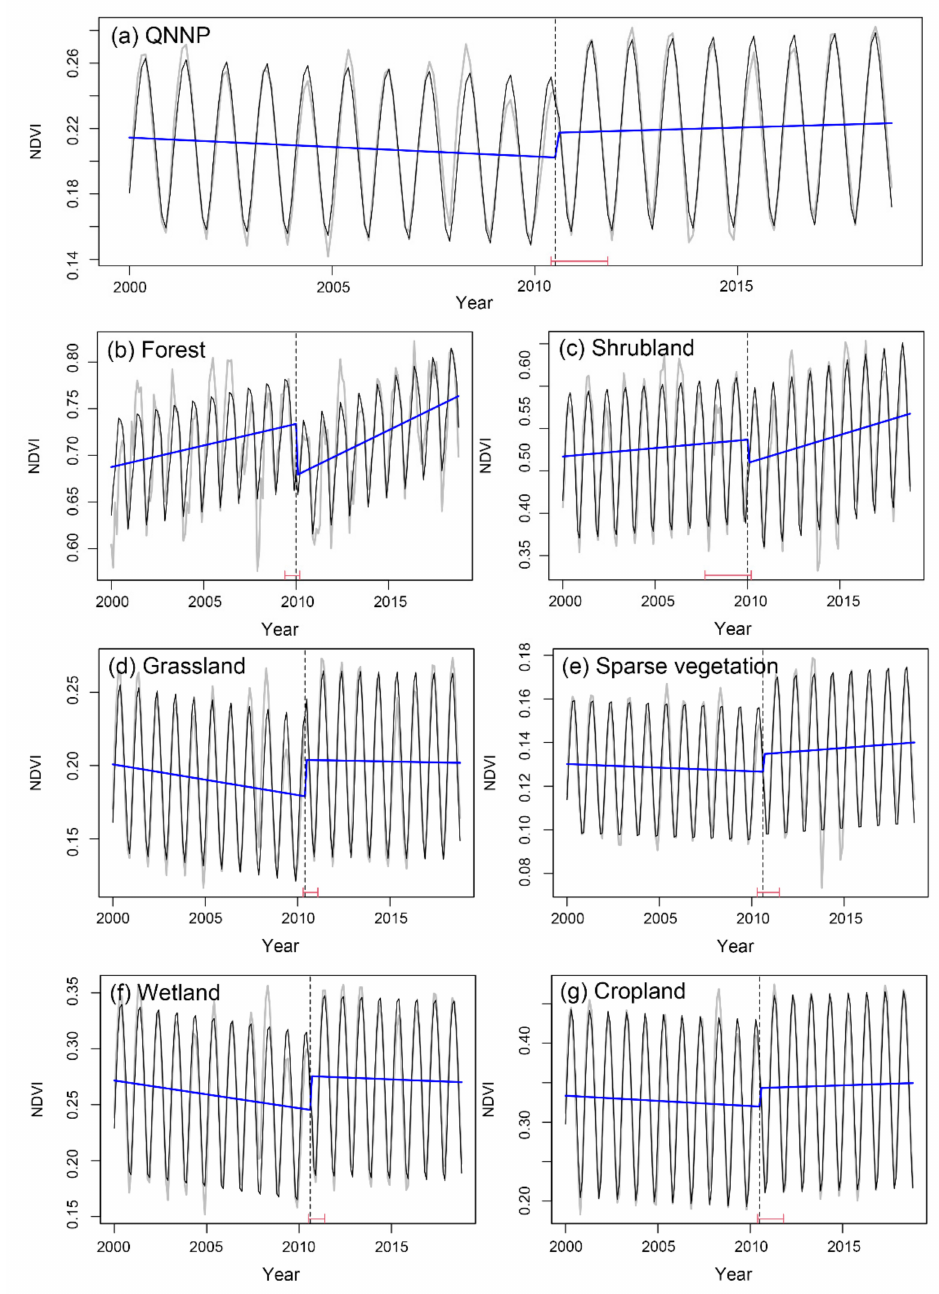
Figure 4. Shifts in trends of NDVI within the time series of the QNNP ( a ) and other vegetation types ( b – g ) during 2000–2018. The black lines represent the seasonal trend model fitted to the original NDVI series (gray lines). The vertical, dashed black lines describe the times of shifts, and the red lines are the confidence intervals. The blue lines are the separated trends detected before and after the shift